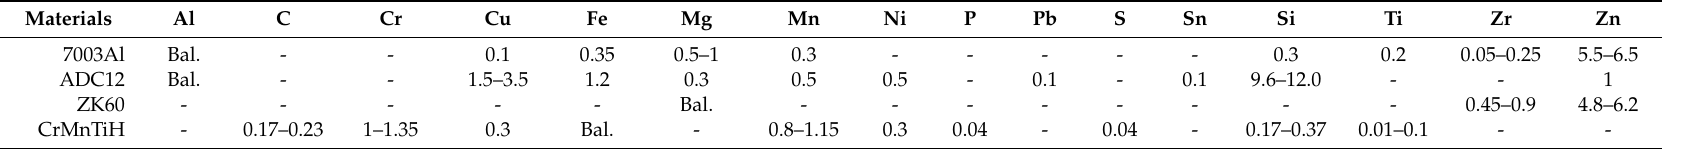
Table 1. Chemical composition of the materials used in the study (wt.%). The single value means the maximum value of element’s concentration.